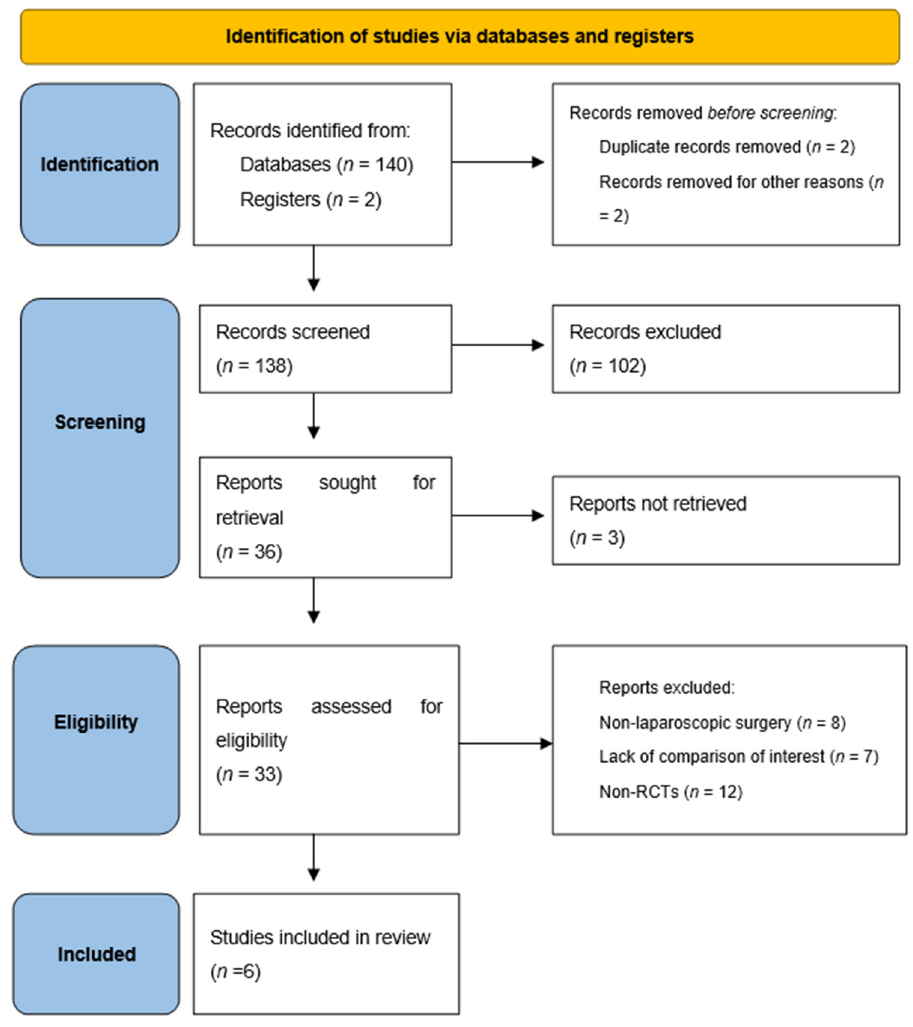
Figure 1. PRISMA 2020 flow diagram of the study .